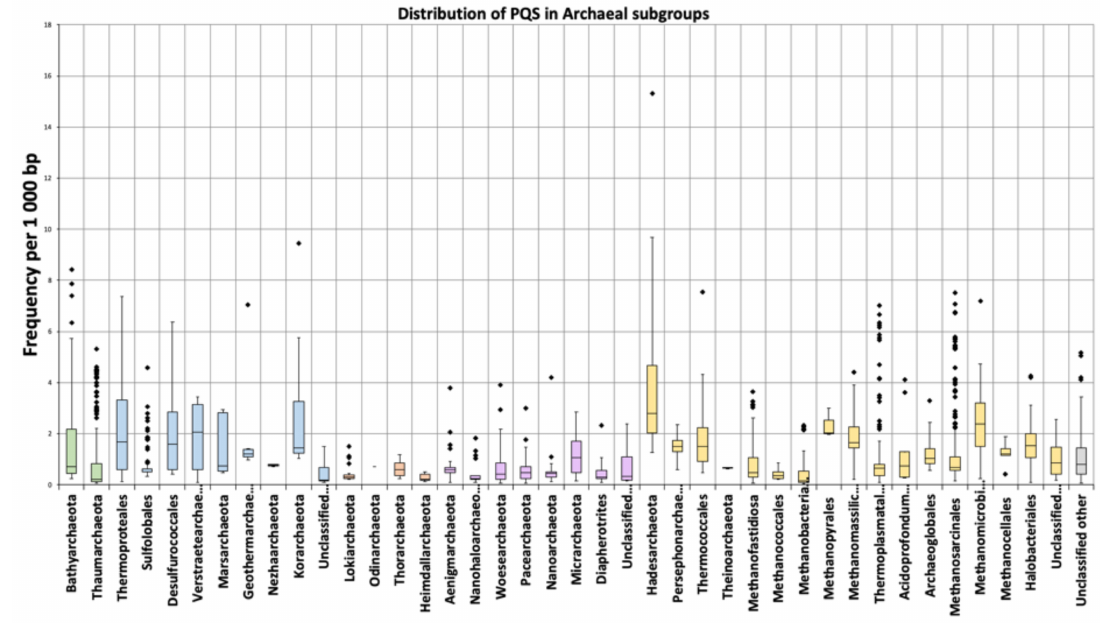
Figure 4. Frequencies of PQS in subgroups of analyzed archaeal genomes. Data within boxes span the interquartile range, and whiskers show the lowest and highest values within 1.5 interquartile range. Black points denote outliers. Horizontal black lines inside boxplots are median